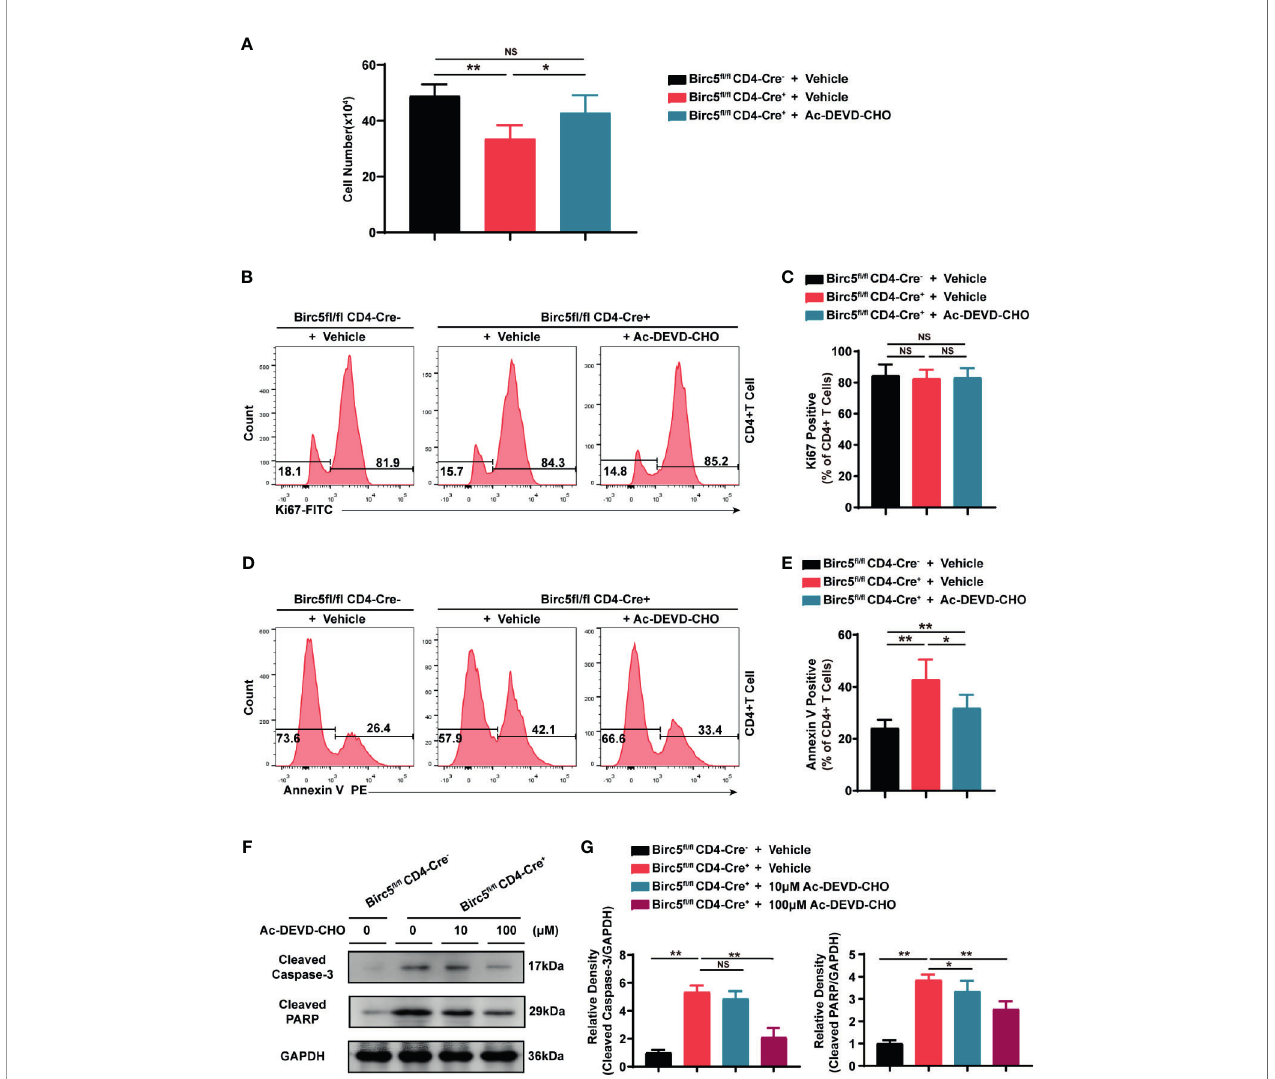
FIGURE 5 | The apoptosis induced by Birc5 knockout in T cells was partly dependent on caspase3. (A) The number of CD4 + T cells isolated from the spleen of WT or Birc5 -/- mice before and after activation in vitro . (B – E) Representative histogram plots of (B) Ki67 and (D) Annexin V positive cells. (C, E) Bar graphs indicating the percentage of the parent gated T cells isolated from the spleen of WT or Birc5 -/- mice at 6-8 weeks of age following stimulation with anti-CD3/CD28 for 48h in vitro . (F) The expression of Cleaved-CASP3 and Cleaved-PARP1 was examined through western blotting after isolating T cells from the spleen of WT or Birc5 -/- mice. The T cells were stimulated in vitro with anti-CD3 Abs for 2 days then treated in the absence or presence of Ac-DEVD-CHO for 24h. GAPDH was used as an internal control. (G) Quantitative data of the groups indicated in (F) . Data are representative of 3 independent experiments (n = 5 per group). The OD values in column graphs are presented as means ± SD, * p < 0.05, ** p < 0.01, ns, not statistically signi fi cant. See also Supplemental Figure 2